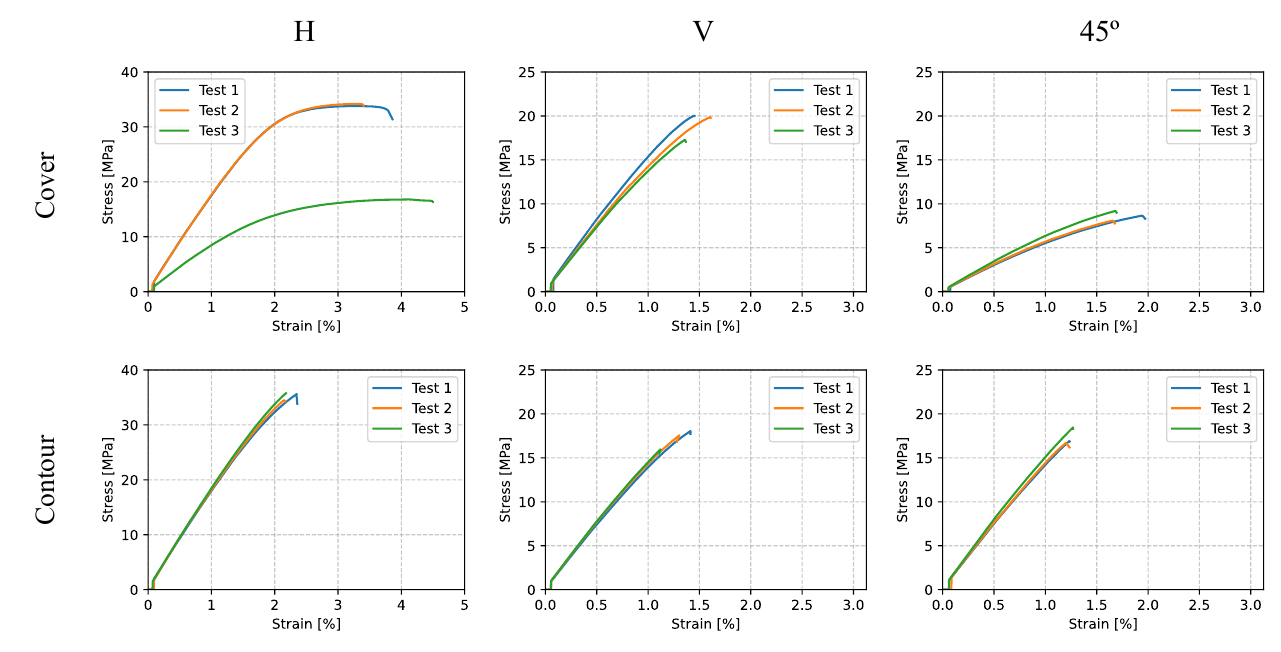
Figure 8. Tensile test stress–strain curves for ABS/PC.